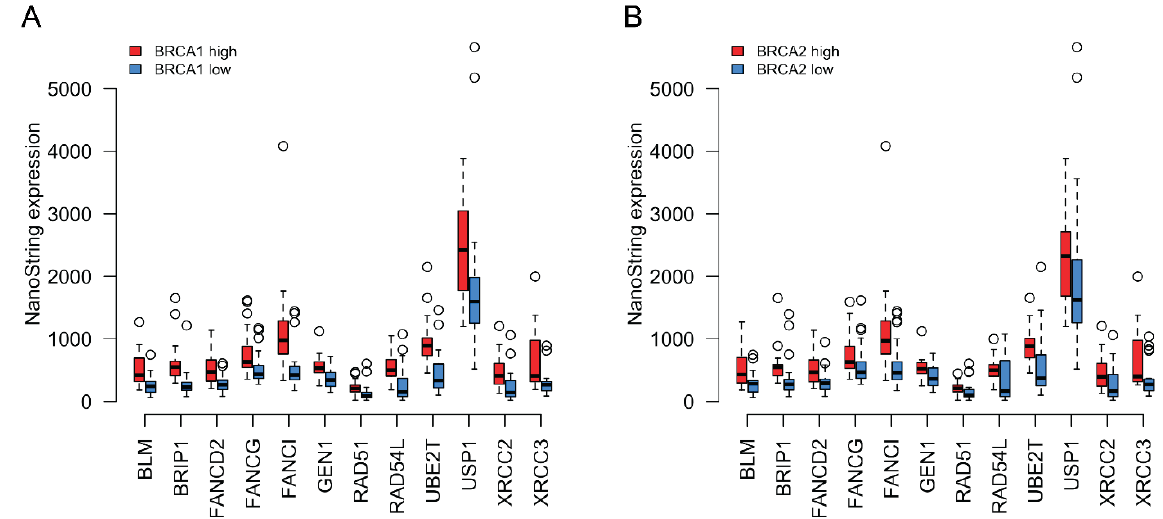
Figure 3. ( A ) Coordinated expression of BRCA1 with other HR genes that were found upregulated in tumors compared to normal tissue. Red boxplots correspond to tumors where BRCA1 expression was equal to or above the median for all tumor samples, whereas blue boxplots represent samples where BRCA1 expression was below the tumor median. The thick horizontal lines show the median. Tumors with higher BRCA1 expression also tended to show higher expression of the other HR genes depicted. ( B ) Similar to ( A ) but classing the tumors based on BRCA2 expression instead.